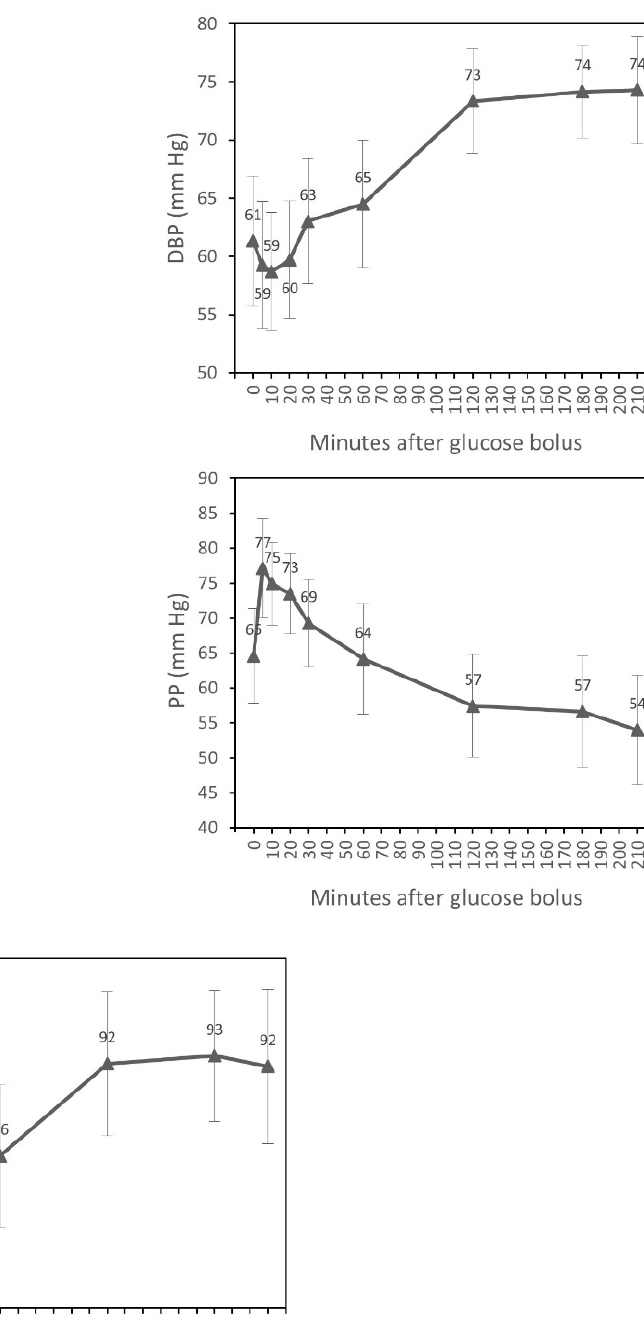
Table 2. Hemodynamic parameters during hemodialysis. T